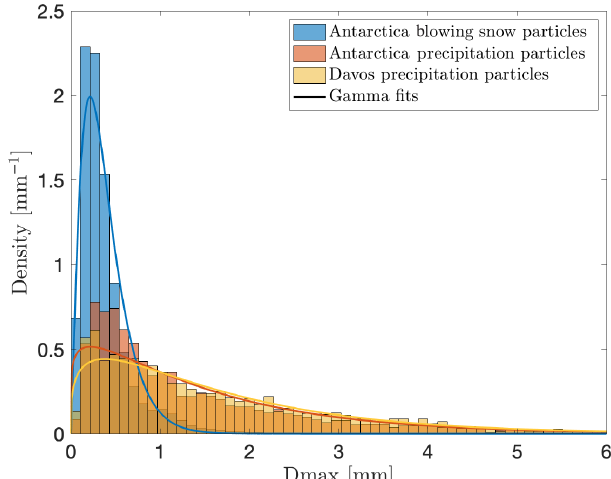
Figure 15. Histograms and fitted gamma distributions of D max for images classified as pure blowing snow and pure hydrometeors from Antarctica and pure precipitation from the